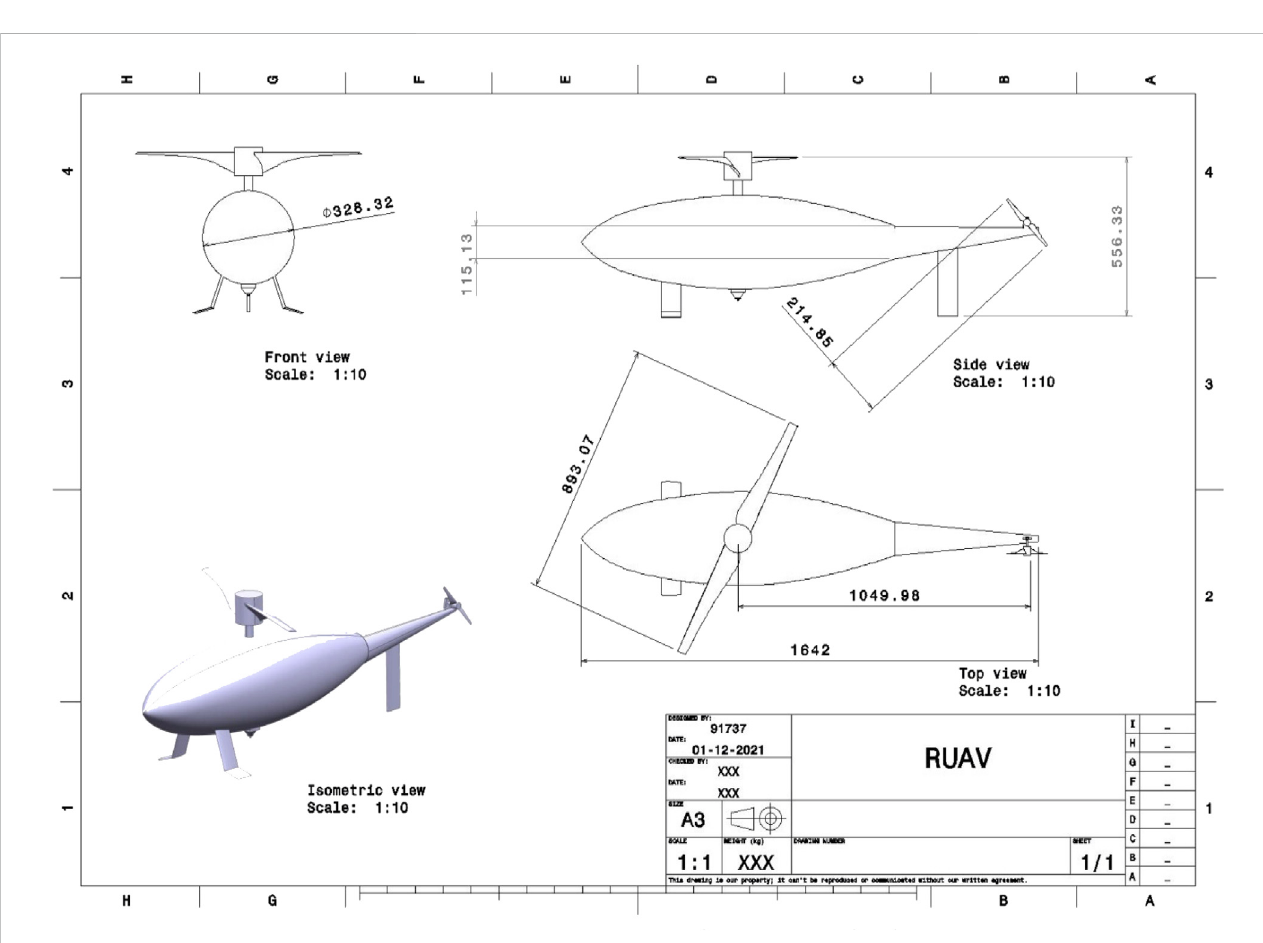
A typical representation of design draft of RUAV